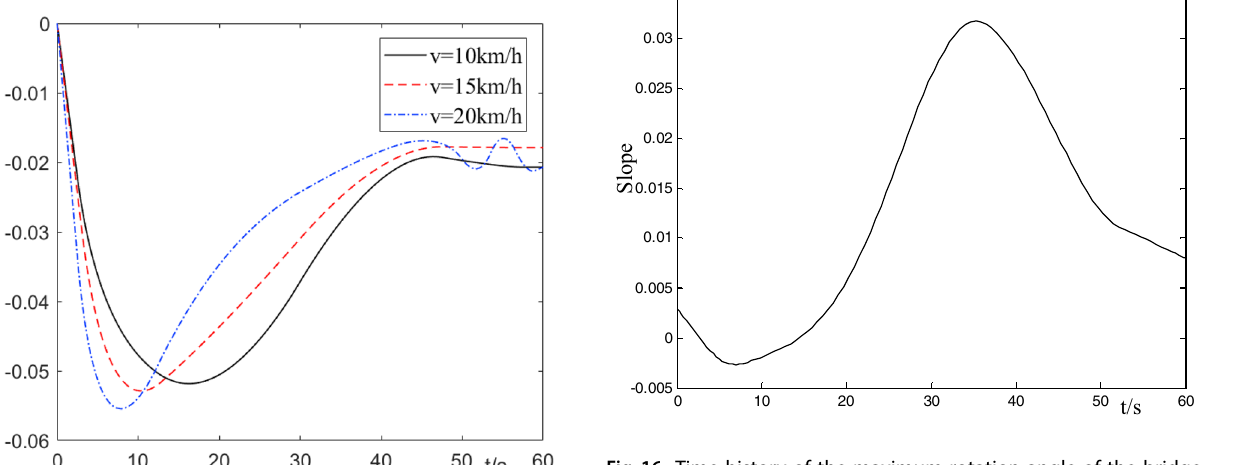
Fig. 16 Time history of the maximum rotation angle of the bridge girder